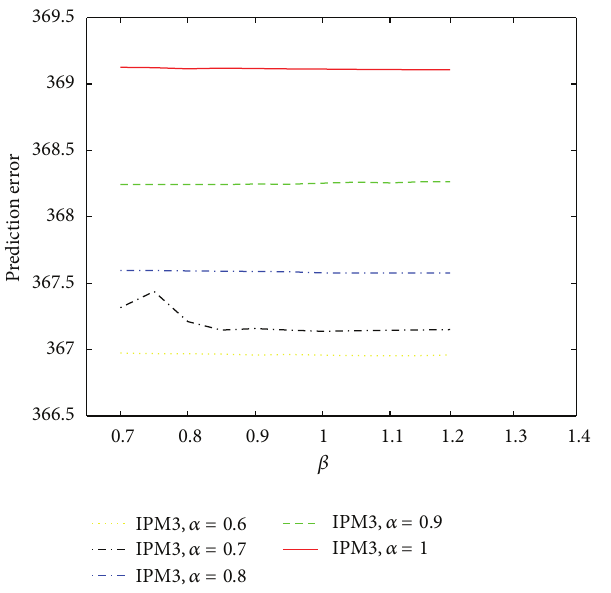
Figure 5: The prediction errors of the new improved parsimonious multivariate Markov chain model with the original convergence condition and the new convergence condition of the new variability in sales demand